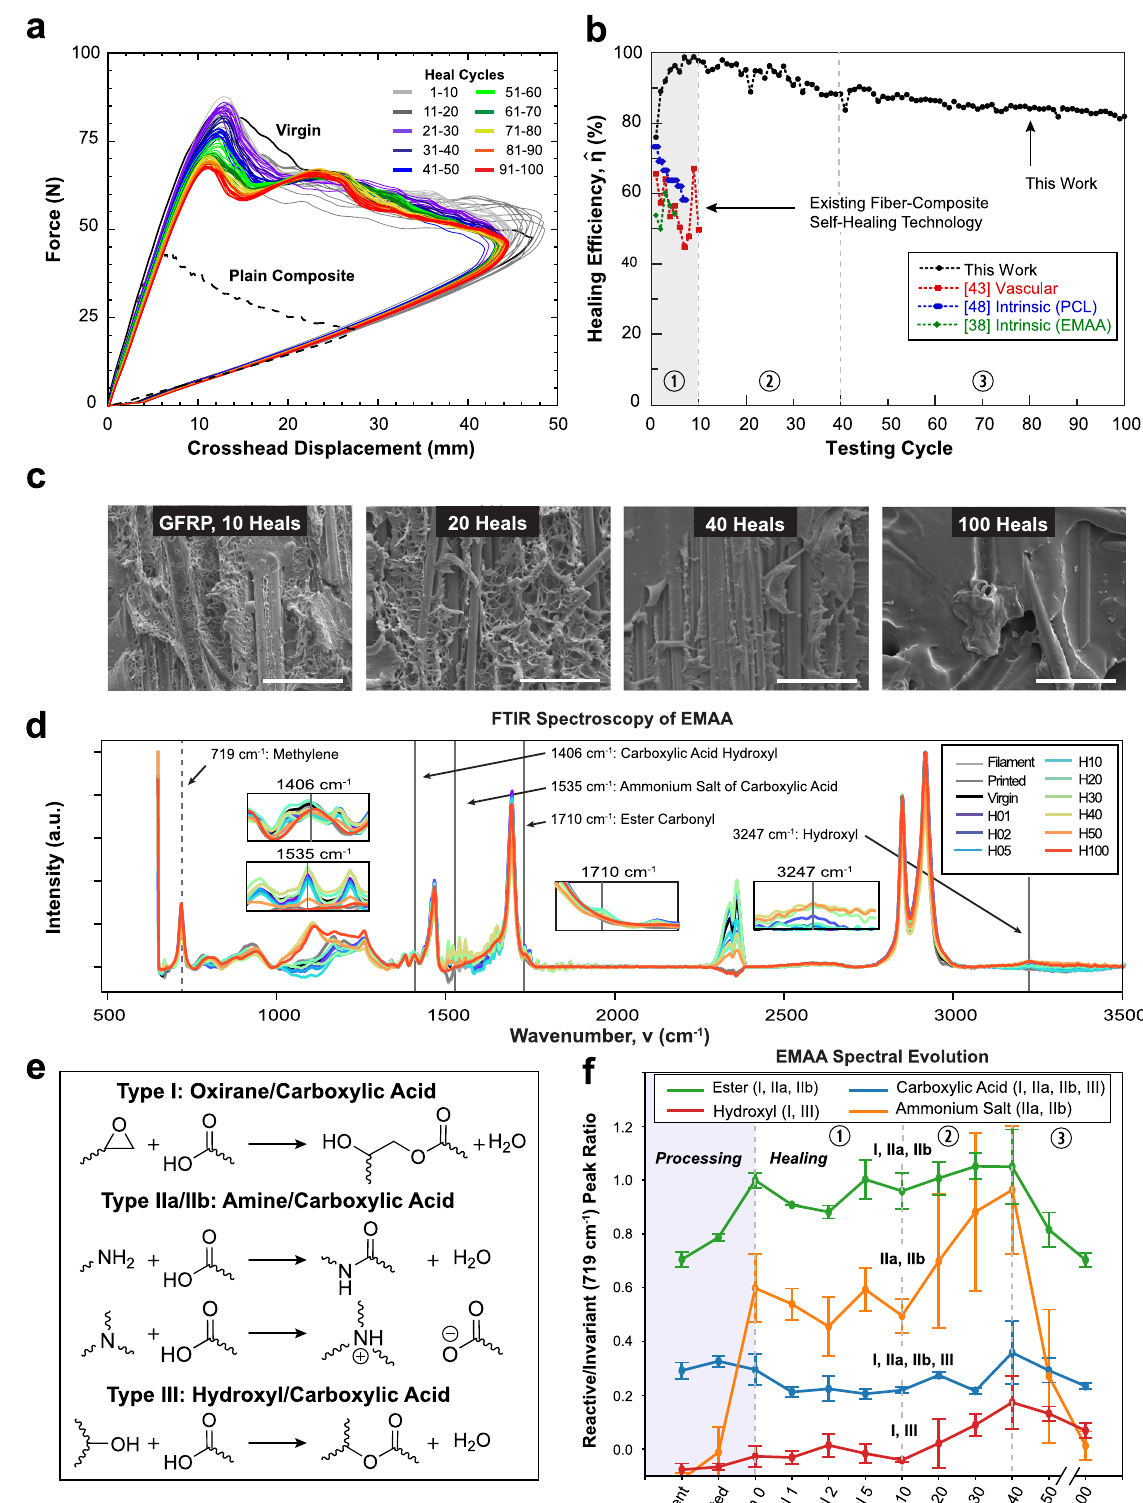
Fig. 5 | Prolonged self-healing demonstration and topological/spectroscopic evaluation. a Fracture behavior for a self-healing GFRP specimen (24% EMAA coverage) tested to 100 heal cycles. b Comparison of healing ef fi ciency ( ^ η ) versus cycle count for the sample in ( a ) and other state-of-the-art self-healing composite technologies from the literature 38,43,48 . c Scanning electron micrographs (SEM) of the fractured GFRP specimen after 10, 20, 40, and 100 heals (scale bars=50 μ m). d Overlaid Fourier-transform infrared (FTIR) spectra of EMAA at varying thermal